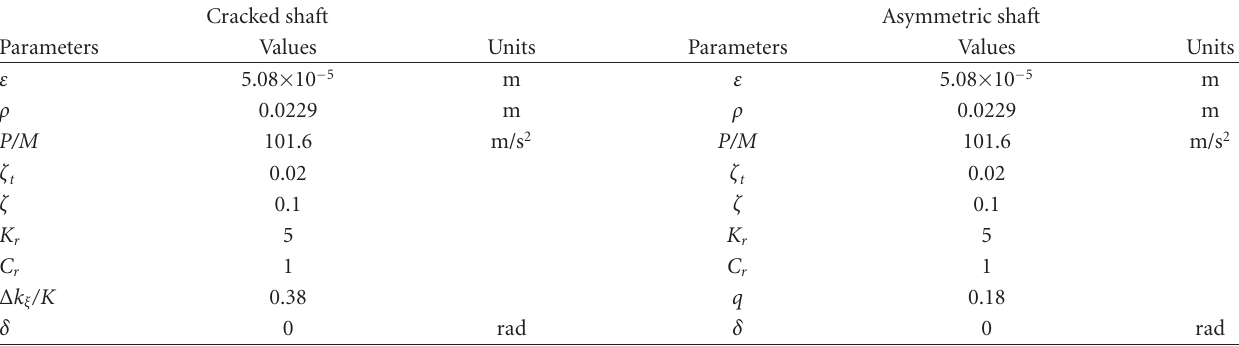
Table 2: Model physical parameters for torsional and lateral vibration, general cases. Cracked shaft Asymmetric shaft